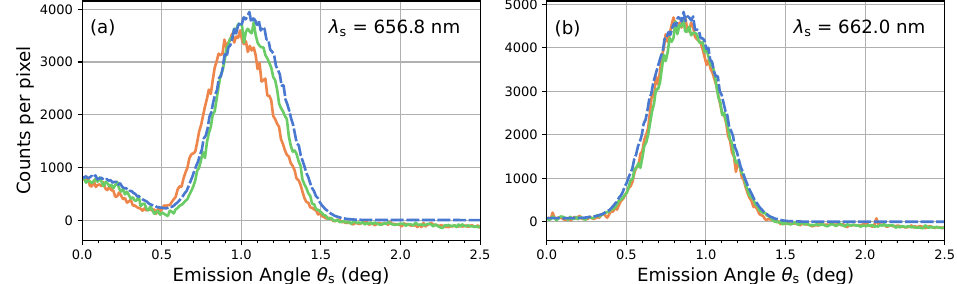
Figure 3: Horizontal cut through the experimental and simulated spectra at θ The positive and negative sign for θ half of Fig. 2 respectively. The simulated spectrum is symmetric in θ line is shown.